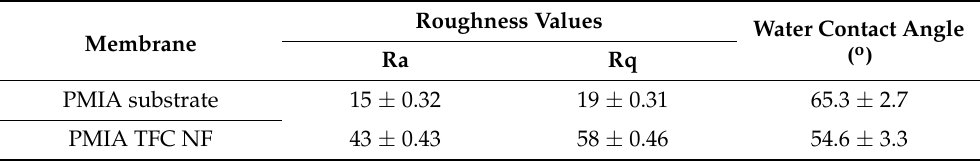
Table 2. Surface properties of